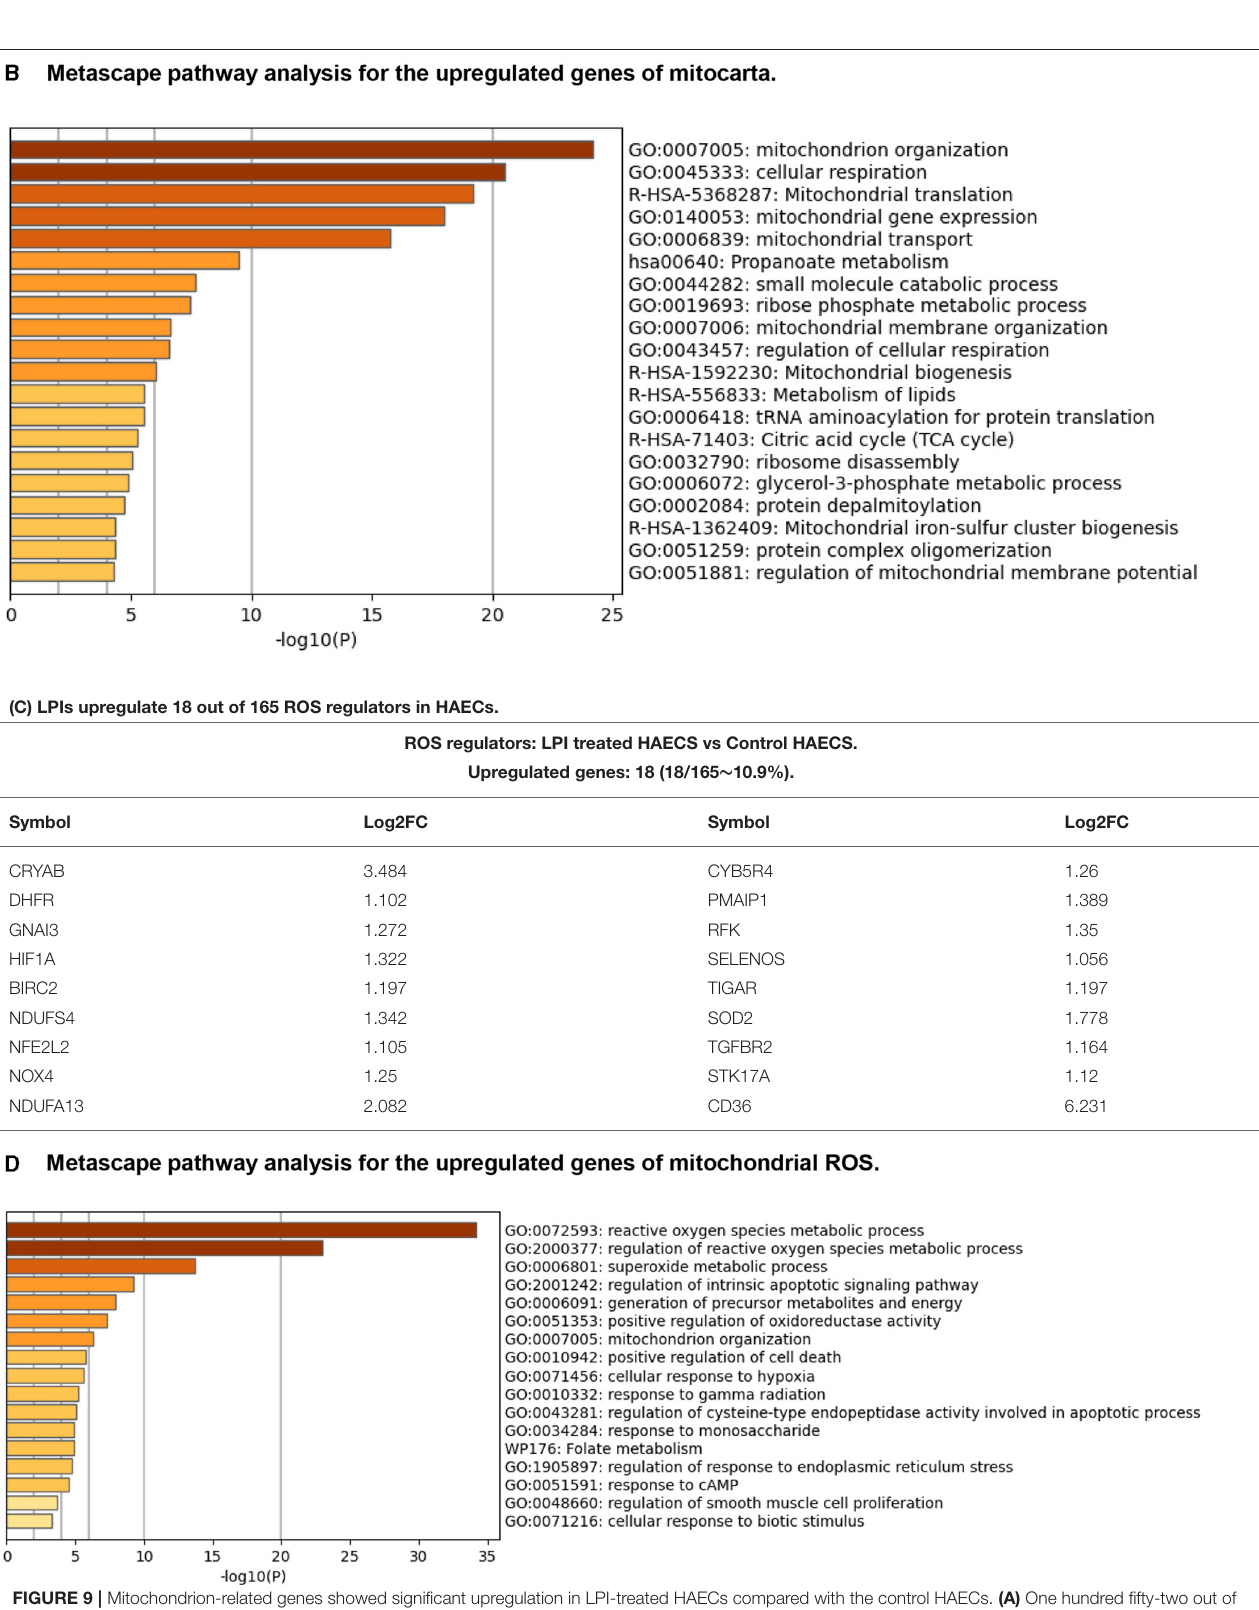
Frontiers in Cardiovascular Medicine |